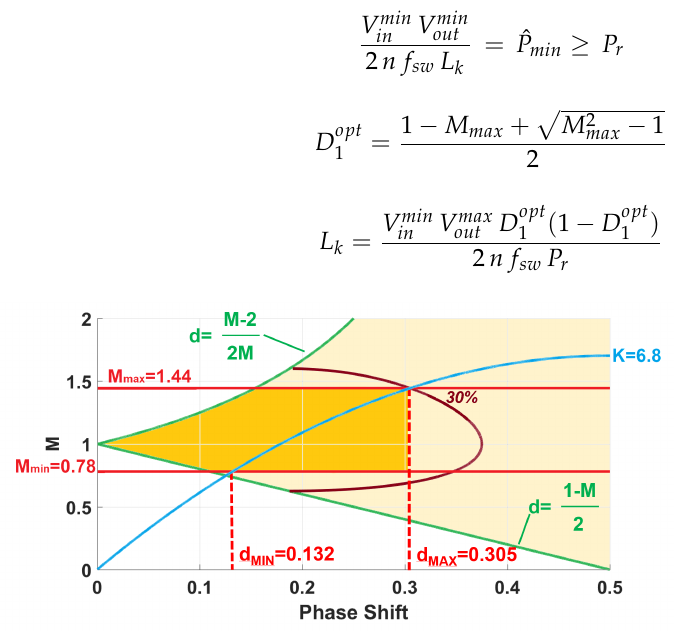
Figure 11. Analysis of DAB converter ZVS range at rated power for the case study. Table 3. DAB converter